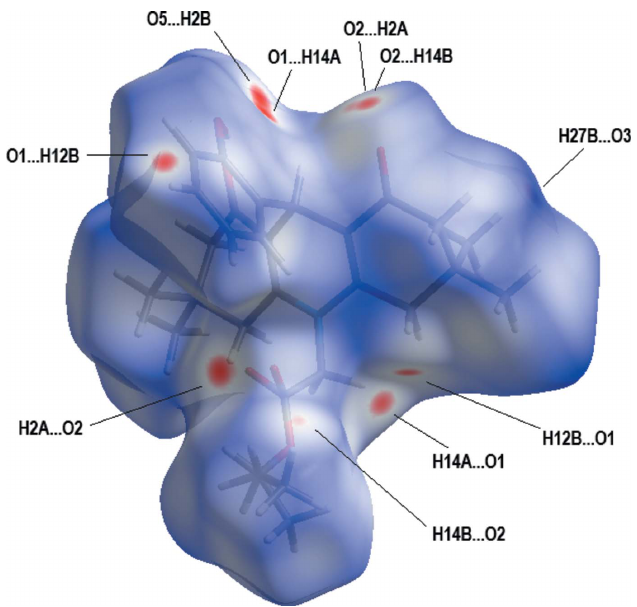
Figure 3 Aview of the three-dimensional Hirshfeld surface for the title compound, plotted over d norm in the range (cid:5) 0.14 to 1.68 An illustration of the inter-molecular contacts in the crystal is given by two-dimensional fingerprint plots.